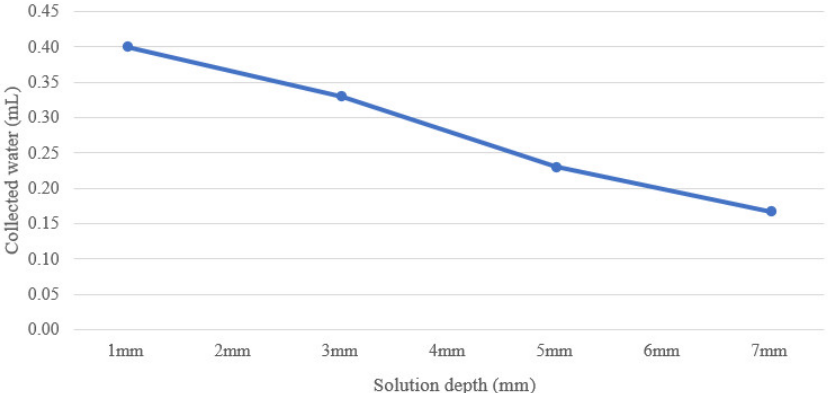
Figure 19. The effect of solution depth on collected water.